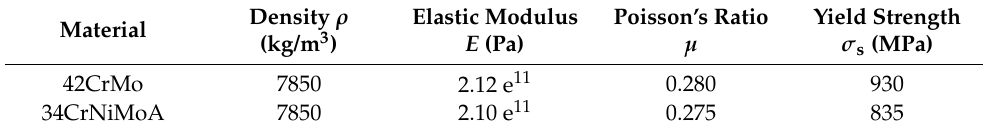
Table 1. Material properties of extrusion